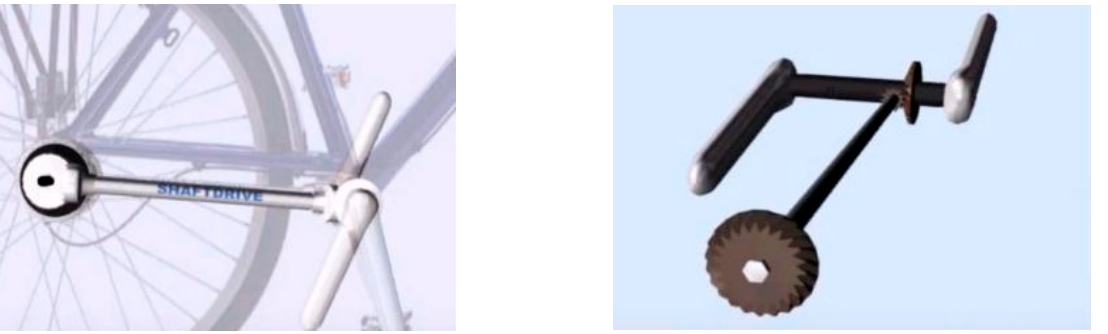
Figure 14. Functioning of the cardanic transmission.